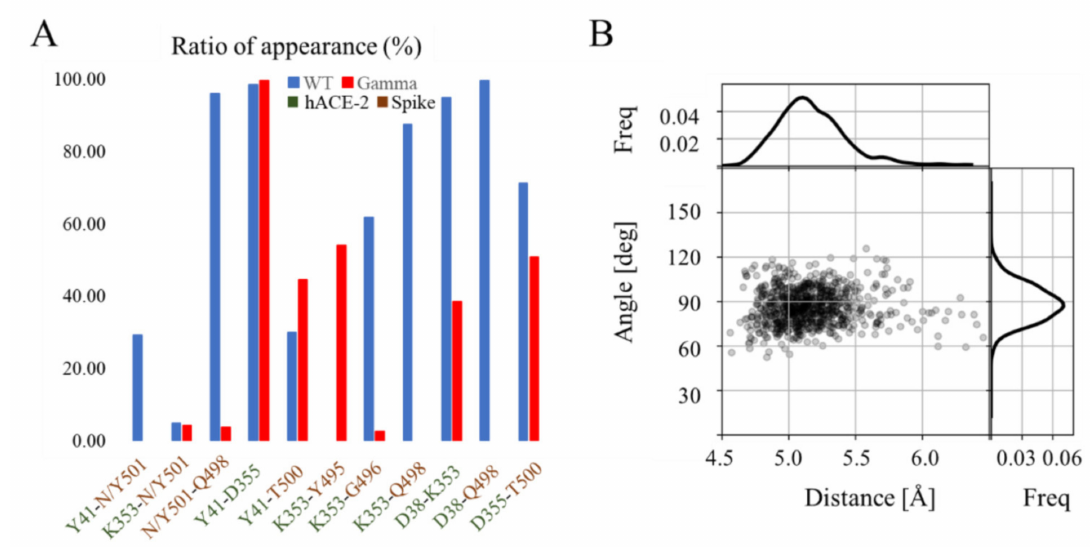
Figure 4. Structural highlights of the N501Y mutation. ( A ) Ratio of appearance (%) of the hydrogen binding partners with N(Y)501 residue throughout the last 80 ns of simulation for the wild type complex (blue) and gamma variant complex (red)). ( B ) Distance-angle chart of the π - π interaction between Y501 and Y41. Each dot in the plot represents the geometric center distance and normal vectors angle between the corresponding aromatic groups. Histograms for each single variable are presented at the edge of the